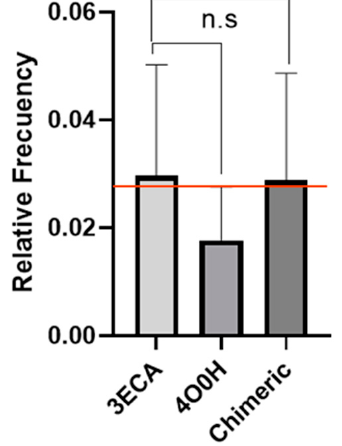
Figure 1. Relative frequency of T-cell immunogenic epitopes for 3ECA, 4O0H proteins, and human- ized 3ECA chimeric protein (Chimeric). Statistical analysis of the relative frequency of predicted T-cell immunogenic epitopes for the chimeric enzyme according to the number of immunogenic peptides of HLA-DRB1*01 alleles: 01, HLA-DRB1*03:01, HLA-DRB1*04:01, HLA-DRB1*07:01, HLADRB1*08:01, HLA-DRB1*11:01, HLA-DRB1*13:01, and HLADRB1*15:01, which are reference alleles in the literature with a wide global frequency. The results showed no significant differences between the relative frequencies calculated for both enzymes, with a probability of p = 0.075. The red line shows the slight numerical decrease between the native and chimeric enzymes. To compare the epitope density of the enzymes, a Tukey test ( p < 0.05) was performed with the mean epitope densities using the statistical package GraphPad Prism version 5.0 for Windows (GraphPad Software, San Diego, CA, USA).